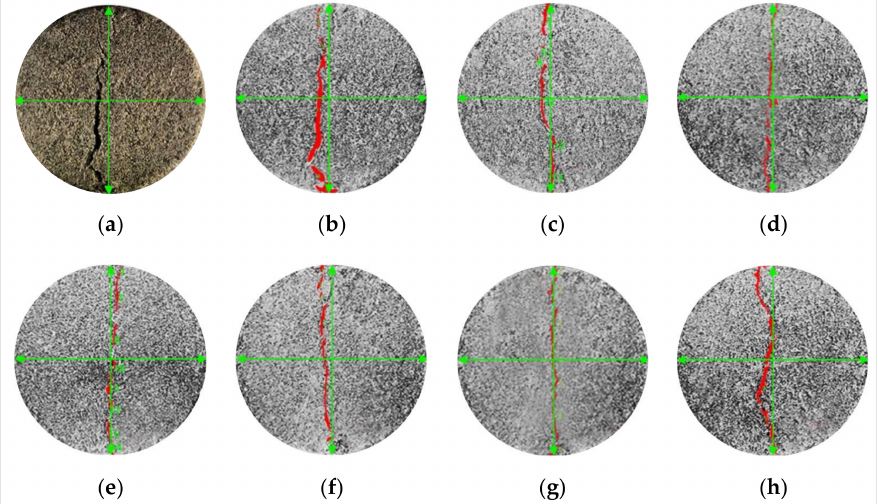
Figure 5. Failure specimen modes. ( a ) Section map; ( b ) None; ( c ) 3‰, 3 mm; ( d ) 3‰, 4.5 mm; ( e ) 2‰, 6 mm; ( f ) 3‰, 6 mm; ( g ) 4‰, 6 mm; ( h ) 6‰, 6 mm.